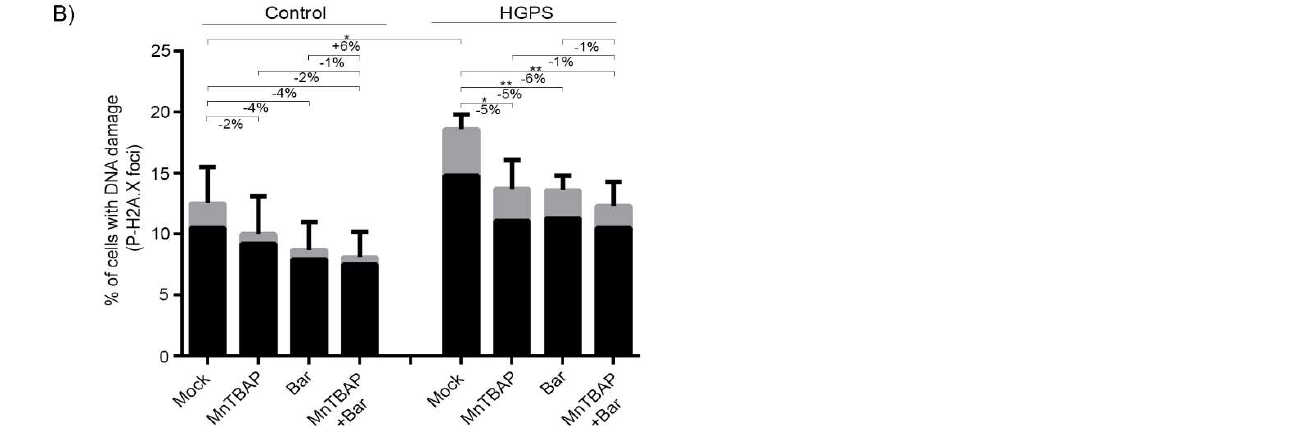
Figure 6. MnTBAP/Bar combination treatment reduces the number of p-H2A.X foci. ( A ) Representative immunofluorescence images of HGPS fibroblasts after 9 d with a mock solution, 5 µM MnTBAP, 1 µM Bar, or the MnTBAP/Bar combination. The cells were stained with anti-phospho histone H2A.X (Ser139) (green) and anti-lamin A (red) antibodies and counterstained with DAPI. ( B ) The number of nuclei with low DNA damage (black) or severe DNA damage (grey) after treatment was scored in at least 900 nuclei for each condition. Graphs show the mean ± SD ( n = 4; * p < 0.05, ** p < 0.01).